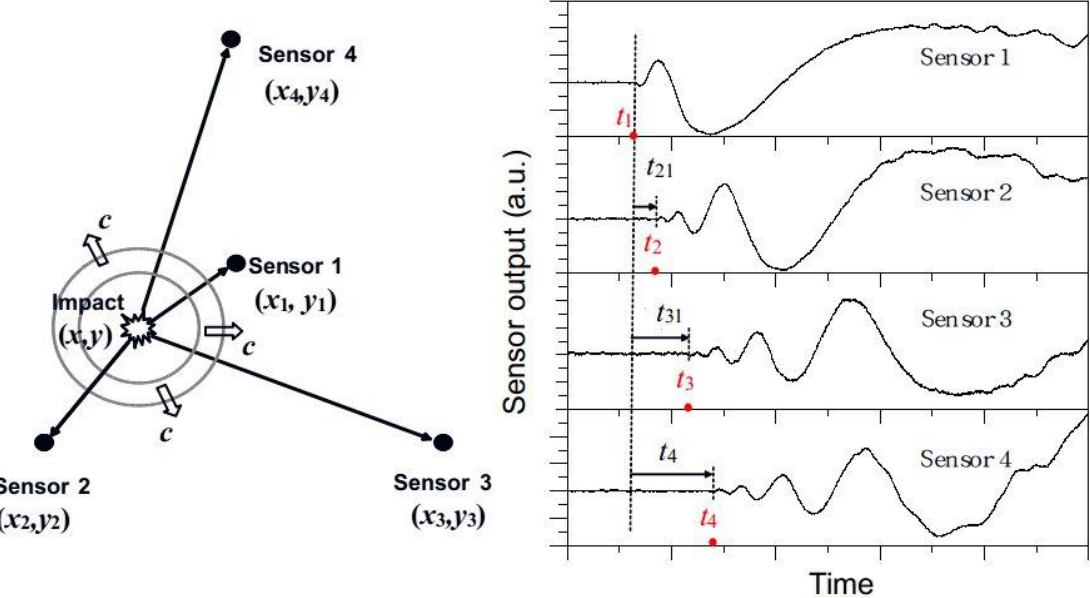
Figure 5. Nomenclature of the four-sensor algorithm to evaluate the impact location.